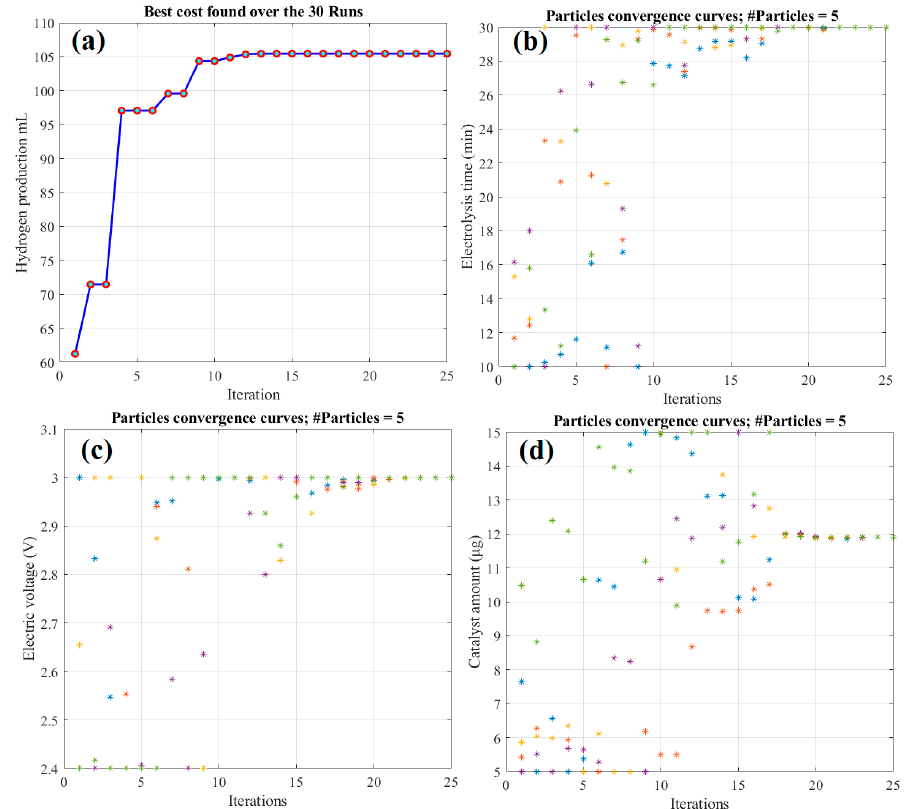
Figure 10. Details of the POA optimization process: ( a ) best cost function over 30 runs, ( b ) particle convergence of electrolysis time, ( c ) particle convergence of electric voltage, and ( d ) particle convergence of catalyst amount.